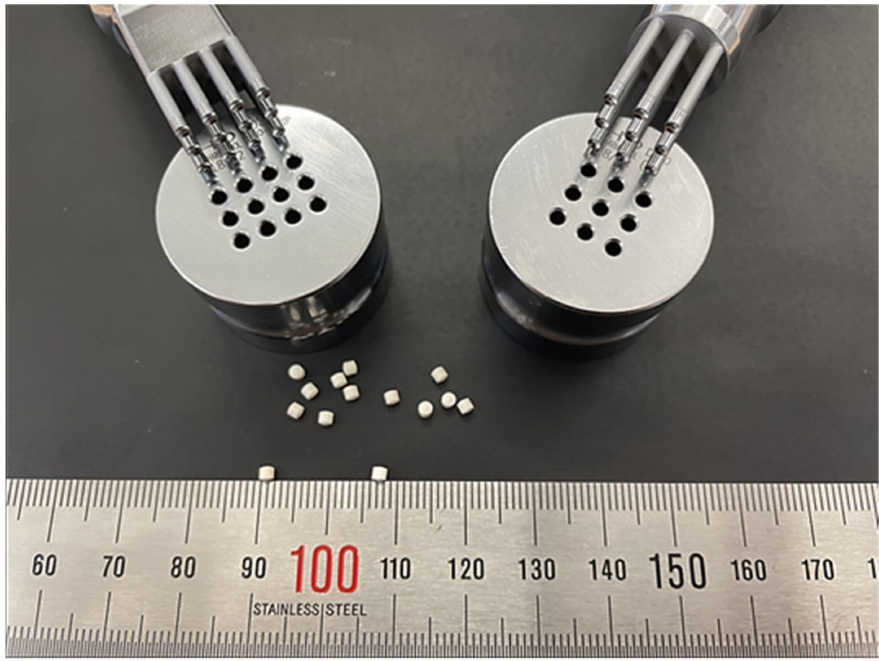
Figure 2. Mini-tablet (2 mm) and multi-tip punches design (left: 12-tip, right: